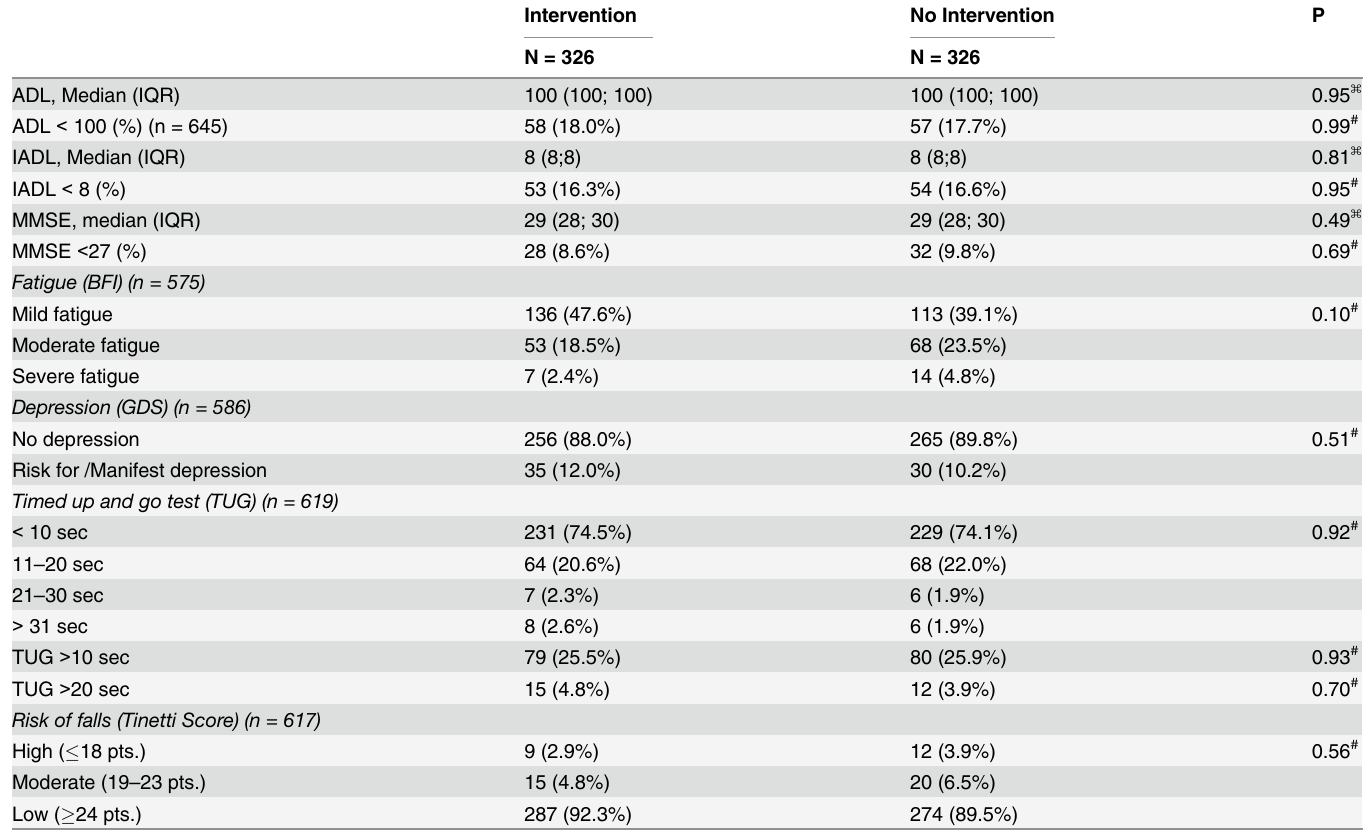
Table 2. Elements of the pre-operative Comprehensive Geriatric